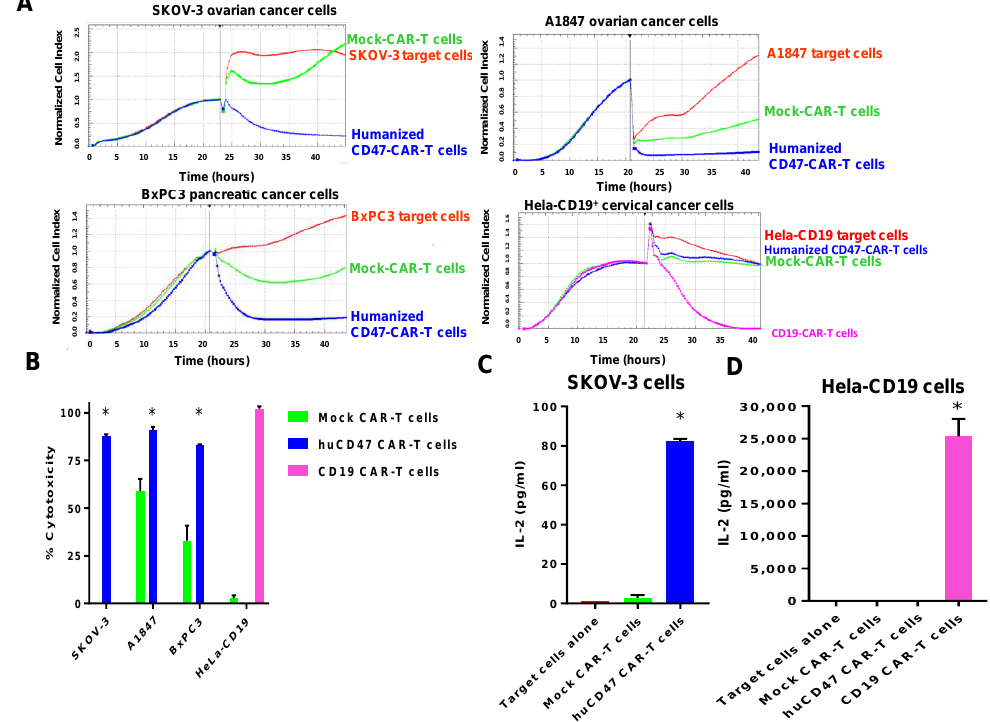
Figure 6. Humanized CD47 CAR-T cells are highly cytotoxic against CD47-positive cancer cells. ( A ) RTCA cytotoxicity assay with humanized CD47-CAR-T cells and CD47-positive or CD47-negative Hela-CD19 cancer target cells. CD47-CAR-T cells cytotoxic against CD47-positive but not against CD47-negative Hela-CD19 cells. Positive control CD19-CAR-T cells effectively kill CD19-positive Hela-CD19 cells; ( B ) Quantification of RTCA assay show significantly increased CD47-CAR-T cell cytotoxicity with CD47-positive cancer cell lines but not with CD47-negative Hela-CD19 cells. * p < 0.001, CD47-CAR-T cells versus Mock-CAR-T cells, Student’s t test. Bars show average percent of cytotoxicity ± standard deviations in three independent experiments; ( C ) Increased secretion of IL-2 by humanized CD47-CAR-T cells with CD47-positive cells SKOV-3 cells. E:T ratio=1:1. p < 0.05, CD47-CAR-T cells versus controls, Student’s t -test, n = 3; ( D ) IL-2 is not secreted by CD47-CAR-T cells with CD47-hegative cells, Hela-CD19 cells. Mock-CAR-T cells are negative control cells. CD19-CAR-T cells are positive control cells against Hela-CD19 target cells. E:T ratio=10:1. p < 0.05, CD19-CAR-T cells versus controls, Student’s t -test, n =